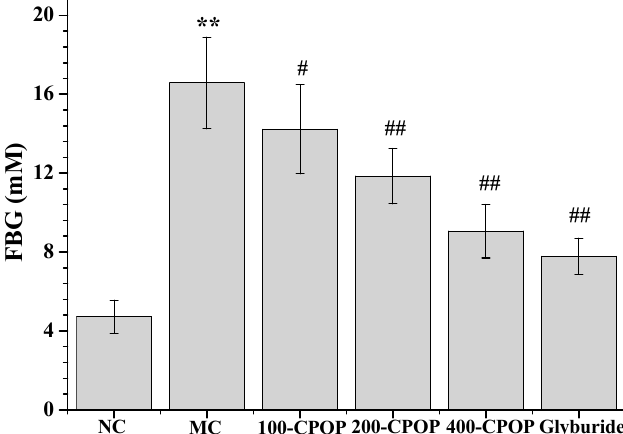
Figure 3. Effect of CPOP on Fasting Blood Glucose (FBG) in Streptozotocin (STZ)-induced diabetic rats. ** p < 0.01 vs. NC group ( N = 8); # p < 0.05, ## p < 0.01 vs. MC group ( N = 8). NC is the normal control group; MC is the model control group; 100-CPOP is the 100 mg/kg per body weight CPOP group; 200-CPOP is the 200 mg/kg per body weight CPOP group; 400-CPOP is the 400 mg/kg per body weight CPOP group.